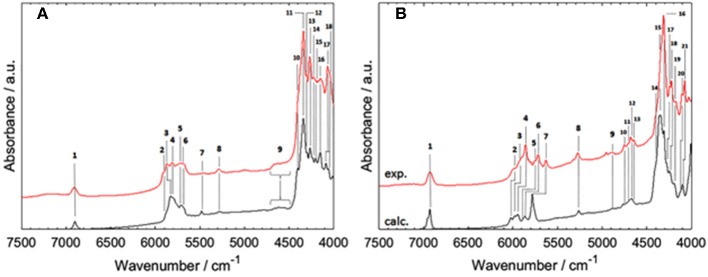
Band assignments proposed for NIR spectra of MCFAs in medium to high concentration (CCl4); (A) hexanoic acid, (B) sorbic acid. Reprinted with permission from Elsevier (Grabska et al., 2017d).